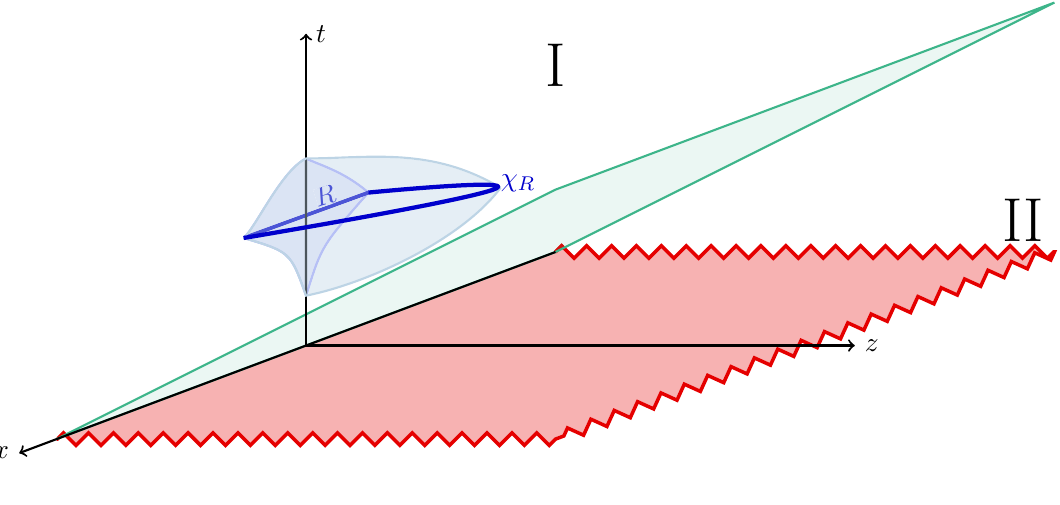
Figure 5 . The entanglement wedge EW contracting branch ( p < 0) stays in region I. Its boundary causal domain D region R is sub-horizon length. The entanglement wedge has a spacelike profile due to